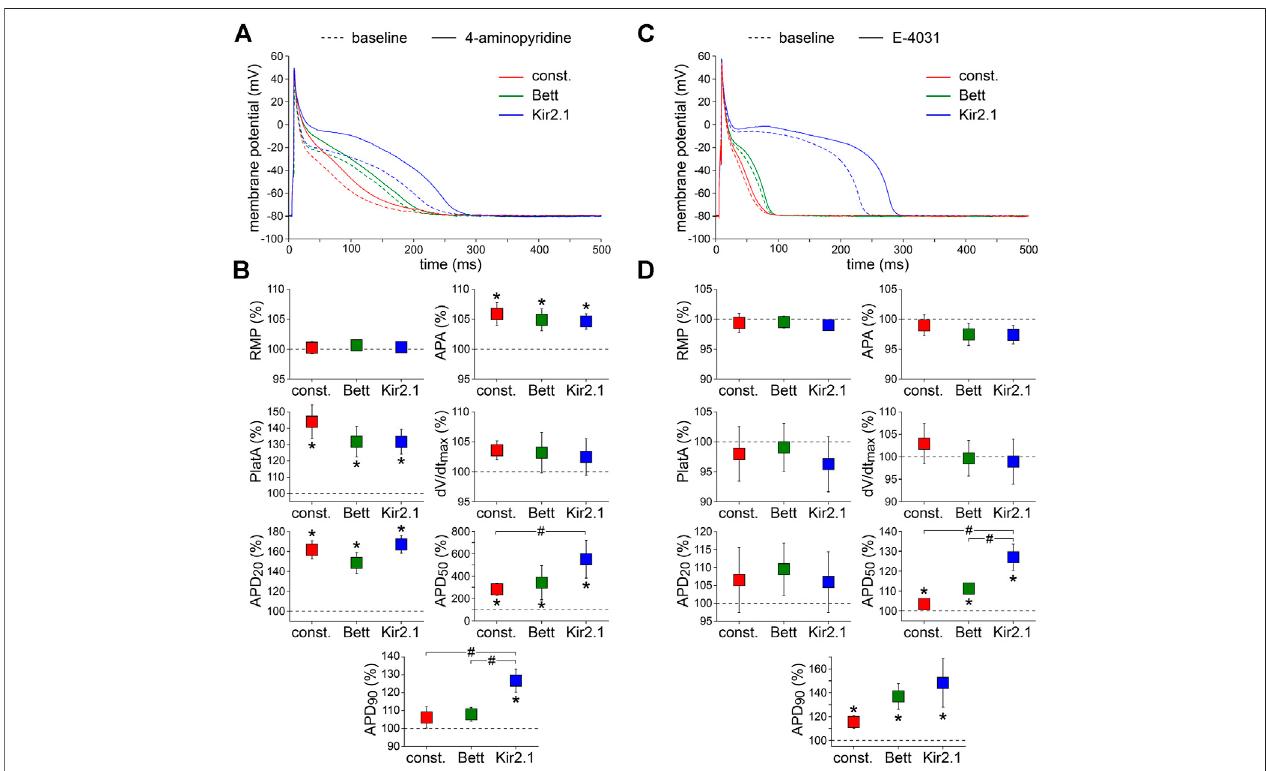
FIGURE 4 | Effects of delayed recti fi er K + current blockade on APs measured with constant and I K1 current injection. (A) Typical APs of one atrial myocyte in absence (baseline) and presence of low dose 4-aminopyridine (4-AP) to block the ultra-rapid delayed recti fi er K + current. (B) Average AP parameters measured in fi ve cellsinpresenceof4-AP.APparametersarenormalizedtotheAPparametersmeasuredunderbaselineconditionsinthesamecell. (C) TypicalAPsofoneatrialmyocyte inabsence(baseline)andpresenceofE-4031toblocktherapiddelayedrecti fi erK + current. (D) AverageAPparametersmeasuredin fi vecellsinpresenceofE-4031.AP parameters are normalized to the AP parameters measured under baseline conditions in the same cell. * p < 0.05, drug vs. baseline (paired t -test); # p < 0.05, drug effects observed with constant current, Bett current, and Kir2.1 current (ANOVA with follow-up